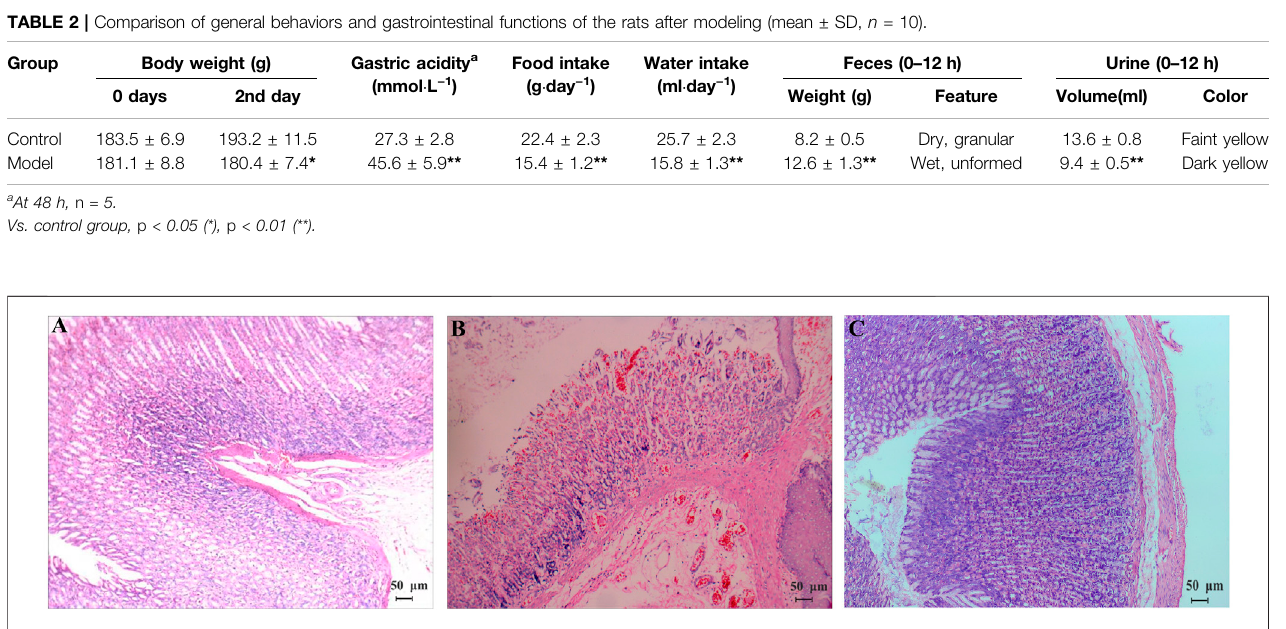
FIGURE1| Pathomorphology(HE, × 100)ofgastricmucosaofnormalrats (A) andmodelrats[ (B) the2nd day; (C) the15th day]. (A,C) Cellsareuniforminsizeand evenly distributed with clear boundaries; (B) gastric mucosa had in fl ammatory cells in fi ltrated and gland destruction, hyperemia and edema, and blurry cell boundaries.